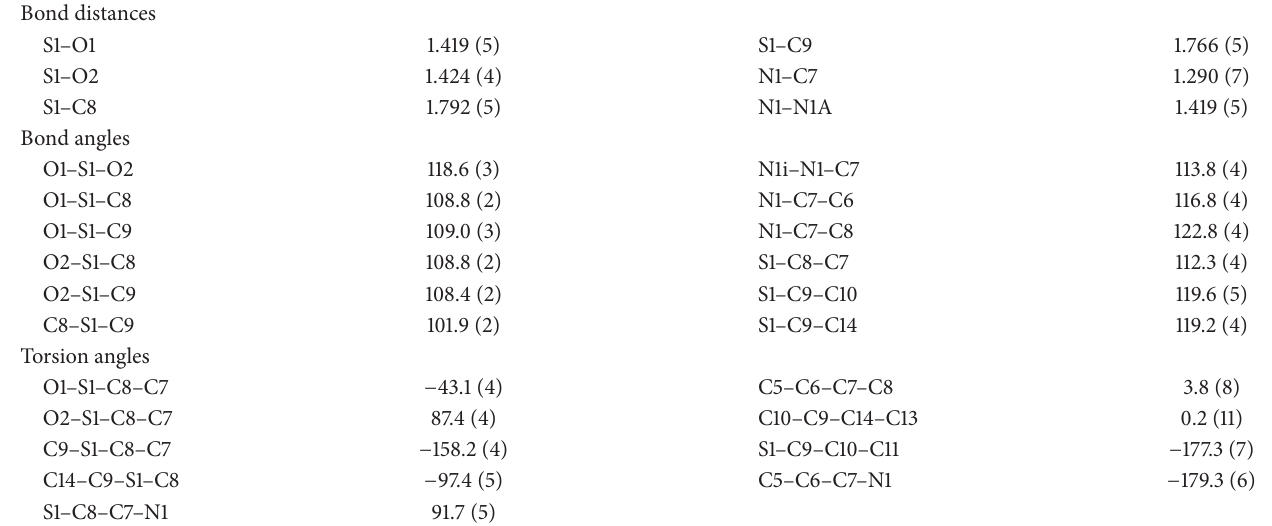
Table 1: Selected bond distances (˚A), bond angles ( ∘ ), and torsion angles ( ∘ ) of compound 5 .